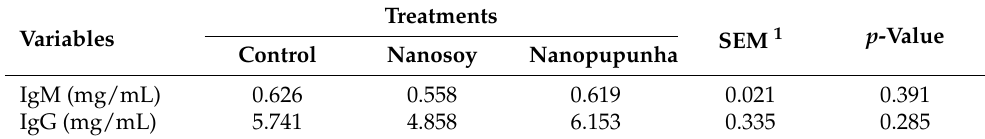
Table 7. Immunoglobulin (IgM and IgG) concentrations in the blood serum of growing rabbits fed different sources of nanofibers and those fed a control